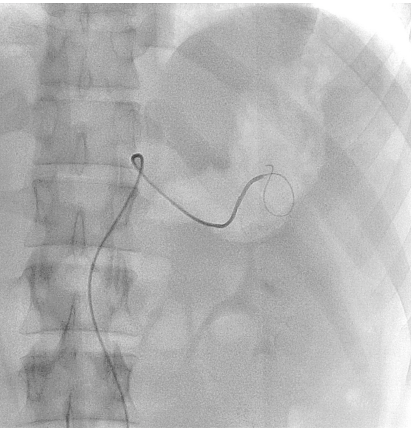
Figure 2: Angiographic catheter cannulating the pseudoaneurysm for coil packing.